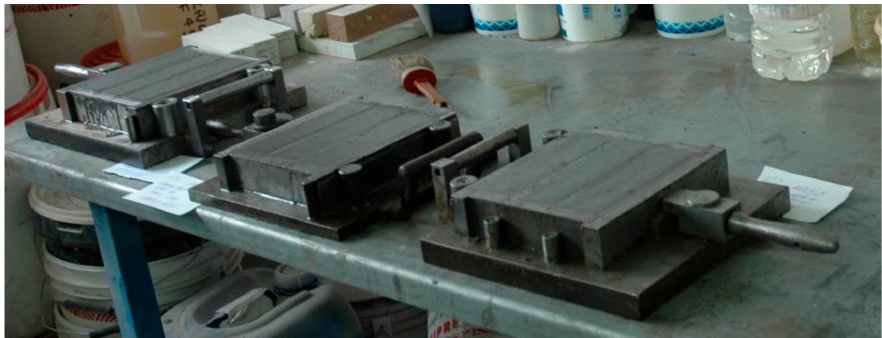
Figure 1. Alkali-activated mortars: casting of prismatic samples for mechanical testing.